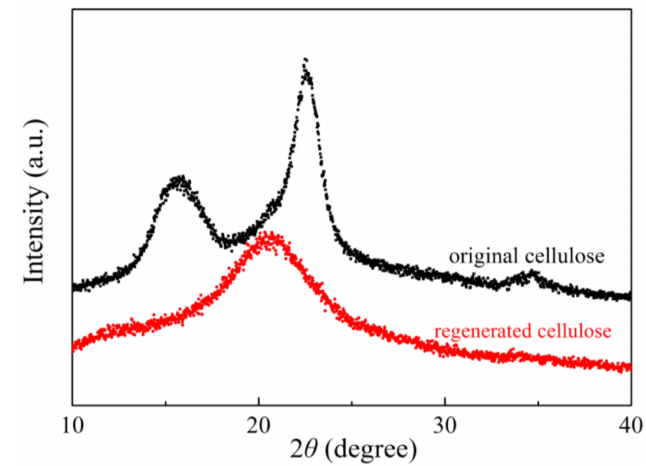
Figure 8. The X-ray diffraction (XRD) spectra of the original cellulose, and the cellulose regenerated from the developed [AAeim][OAc]/DMSO co-solvent